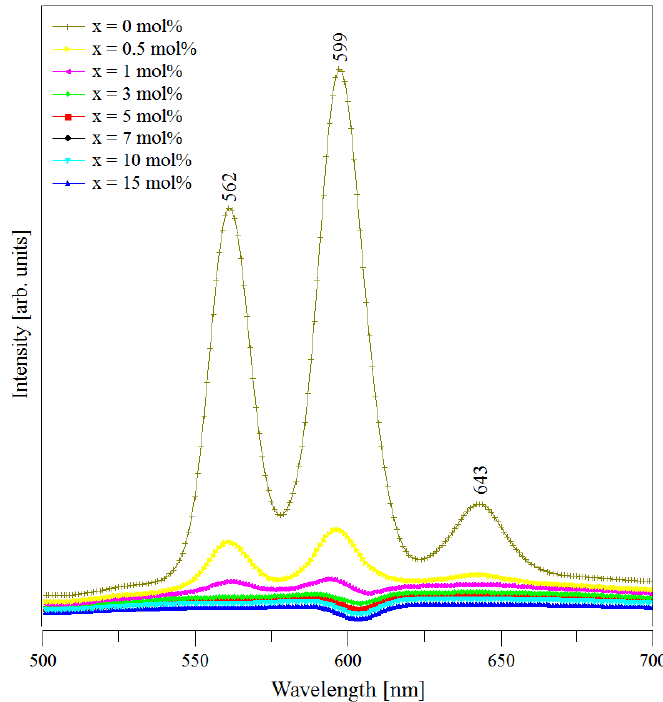
· (P · (Sb · (Sm 2 O 5 ) 35 2 O 3 ) (64 − x) 2 O 3 ) 1